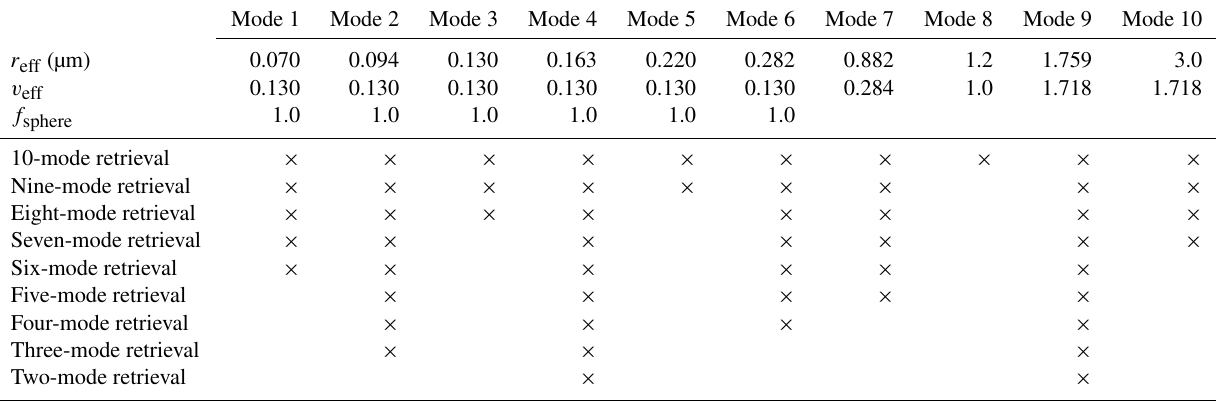
Table 2. Multimode retrieval